Question: In a single sentence, describe what this figure presents.
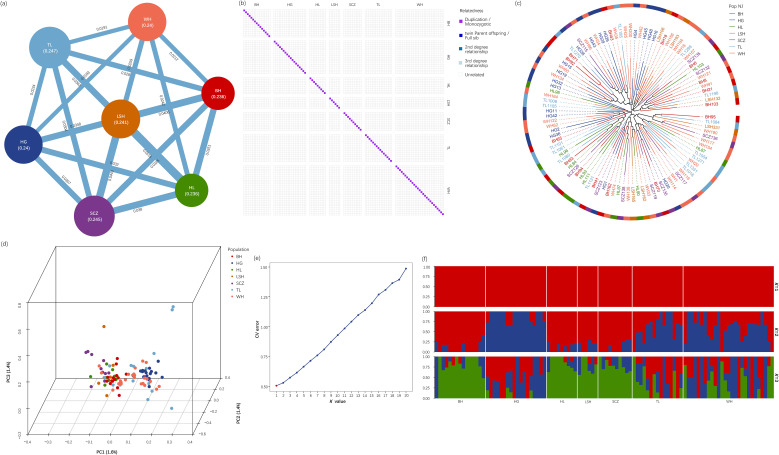
Answer: Genetic differentiation and structure analysis. (a) Pi among populations and Fst between populations. (b) Heatmap of kinship relationships for all individuals. (c) Circular evolutionary branch-length plot (NJ). (d) PCA based on the first three principal components. (e) CV error variation with the K value. (f) Genetic components of samples corresponding to the best K value and the nearest K value.